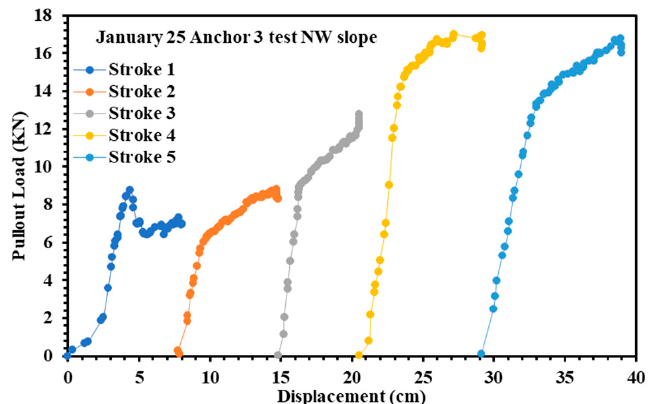
Figure 12. Schematics of field anchor pull-out test. Anchor 3 pull-out test, all strokes, northwest bank, 25 January 2022.